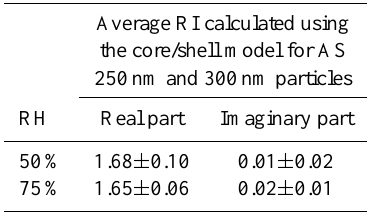
Table 2. The average shell RIs for the reacted particles of the AS at two RH values, retrieved from the core/shell model.